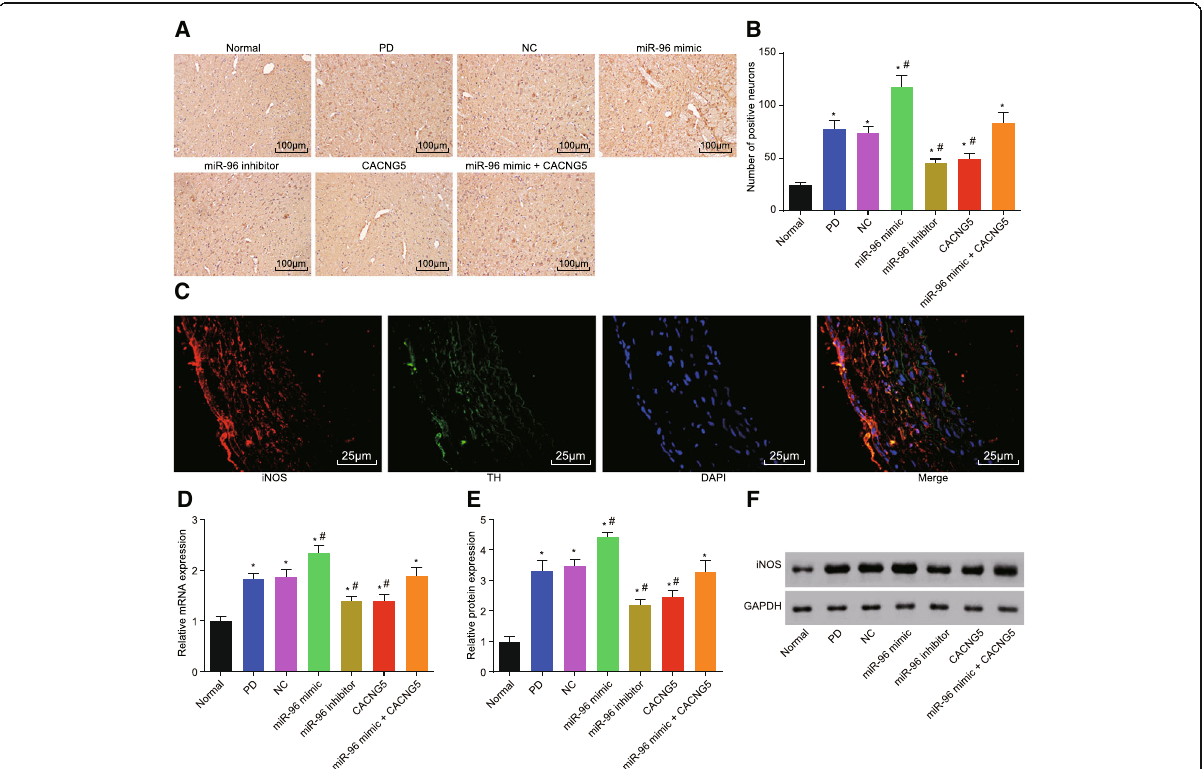
Fig. 5 miR-96 inhibitor results in a decrease in the expression of iNOS in dopaminergic neuronal tissues. a iNOS immunohistochemistry for dopaminergic neuronal tissues among seven groups; b iNOS positive cells among seven groups under a microscope; c immunohistochemistry of colocalization analysis between the TH and iNOS; d mRNA expression of iNOS among seven groups evaluated by RT-qPCR; e protein expression of iNOS among seven groups; f protein bands of iNOS among seven groups evaluated by Western blot analysis; * , P < 0.05 compared with the normal group, # , P < 0.05 compared with the PD and NC groups; Bar = 50 μ m. The test was repeated three times independently, and the one-way ANOVA analysis was used for comparison among multiple groups (n = 10 in each group). iNOS, inducible nitric oxide synthase; RT-qPCR, reverse transcription quantitative polymerase chain reaction; miR-96, microRNA-96; CACNG5, calcium voltage-gated channel auxiliary subunit gamma 5; PD, Parkinson ’ disease; NC, negative